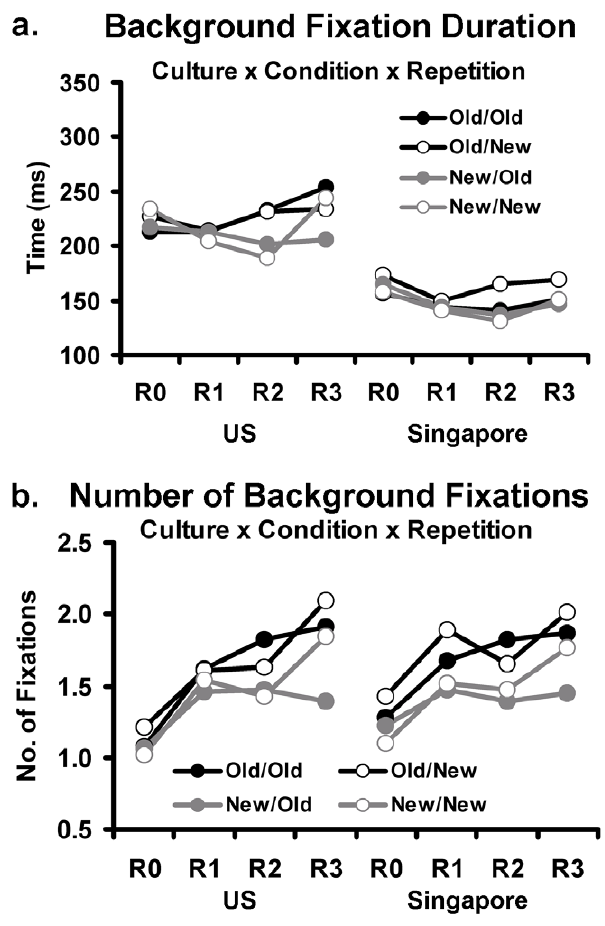
Figure 3. Mean background fixation data for US and Singapore participants. Mean background fixation durations (a) and number of background fixations (b) are shown across all quartet conditions (Old and New objects/backgrounds) and picture repetitions (R0 to